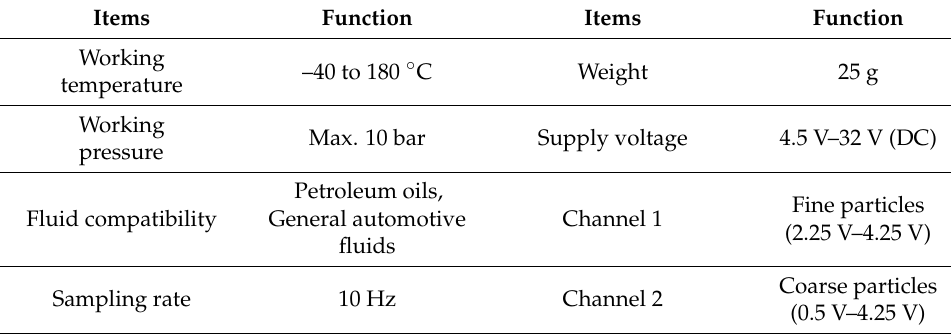
Figure 5. Measured part connected to the ferrous particle sensor. Table 1. Specifications of the ferrous particle sensor.